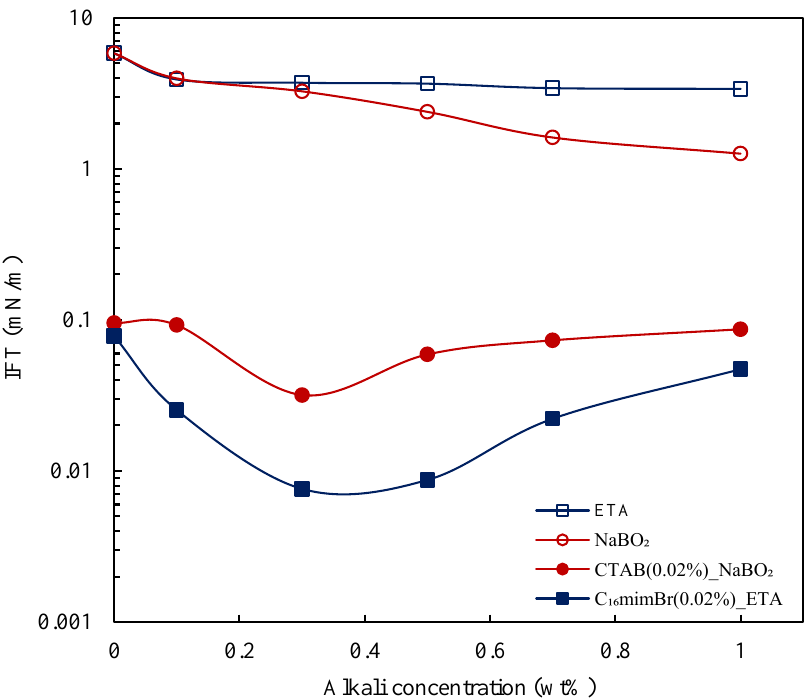
Figure 9. Aqueous – crude oil IFT variation with alkali concentration for chemical solutions at 25 °C. Figure 9. Aqueous–crude oil IFT variation with alkali concentration for chemical solutions at 25 ◦